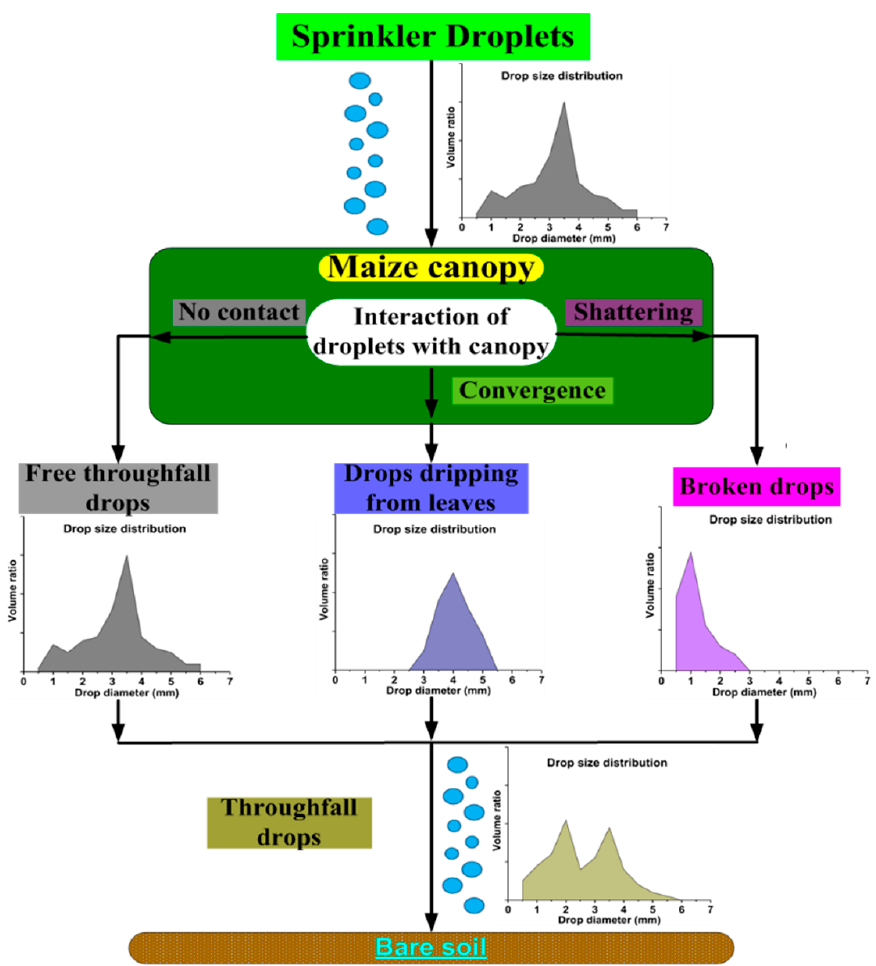
Figure 10. Component of drop size distribution of throughfall.